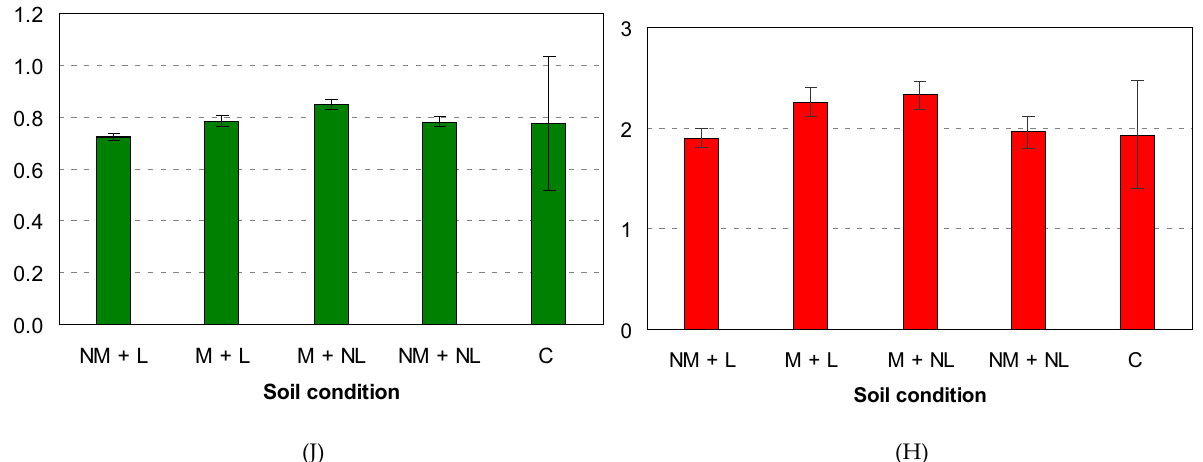
Figure 3. Indexes (S; species richness; J, Piélou; and H, Shannon) to measure the plant species diversity under five post-fire treatments in the experimental site in spring 2017 (Liétor, Castilla La Mancha, Spain).